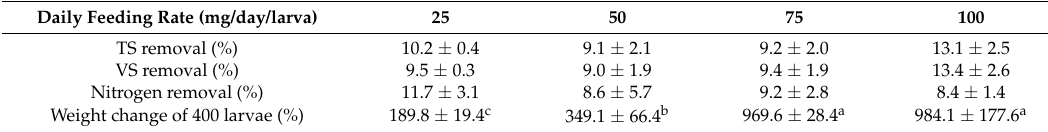
Table 5. Effect of different daily feeding rates on removal efficiency of TS, VS, and nitrogen with black soldier fly larvae weight